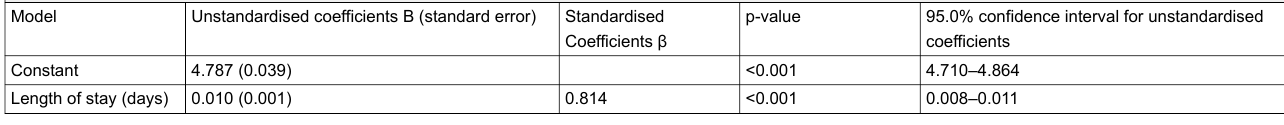
Table S5: Summary of regression coefficients – linear regression model predicting the decadic logarithm of total costs per case, excluding the outlier with a final balance of –1’3 million CHF. Study population: severe burns discharges from all Swiss university care centres (n = 108).